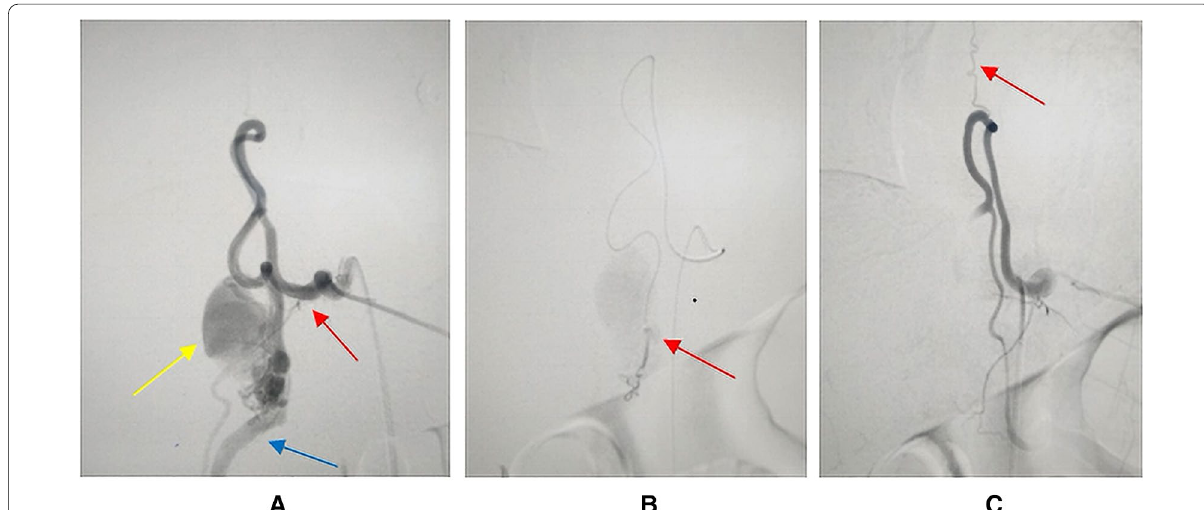
Fig. 2 Digital Subtraction Angiography (DSA) images: A Left D8 intercostal digital subtraction angiogram shows abnormal hypertrophied feeder (red arrow) with intranidal aneurysm (yellow arrow) and draining vein (blue arrow). B Super selective microcatheter run at a fistulous site (red arrow). C Post-glue embolization shows the obliteration of AVM and normal opacification of the anterior spinal artery (red arrow)